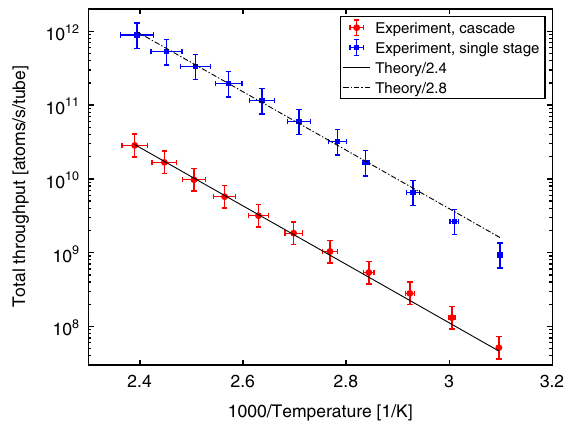
Fig. 4 Output fl ux of the planar atomic beam. Measured throughput of the planar atomic beam for both the ordinary and cascaded collimator geometries con fi rms the factor of 40 suppression of total fl ux in the latter case. Data are in good agreement with the prediction of an effusive fl ux model based on the known Rb vapor pressure. The model throughput has been reduced by a factor of 2.4 (2.8) for the cascaded (ordinary) collimators. Horizontal error bars re fl ect temperature variation across the oven, while vertical error bars re fl ect both calibration errors and uncertainty in determination of peak fl